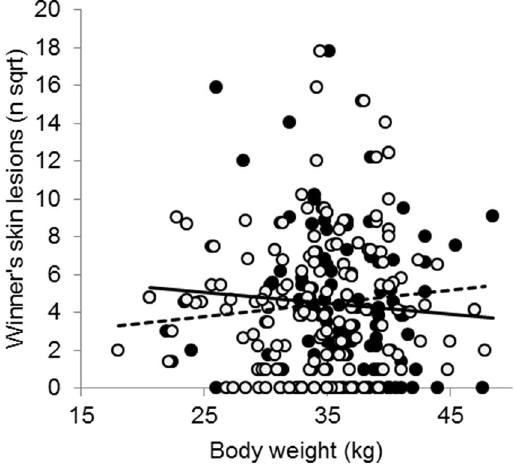
Figure 2. Assessment strategy before experience. The relationship between winner and loser body weight for skin lesions on the winner’s body as measure of contest costs in contest 1. Winners (n = 135): ● / − ; Losers (n = 135): ○ /---.